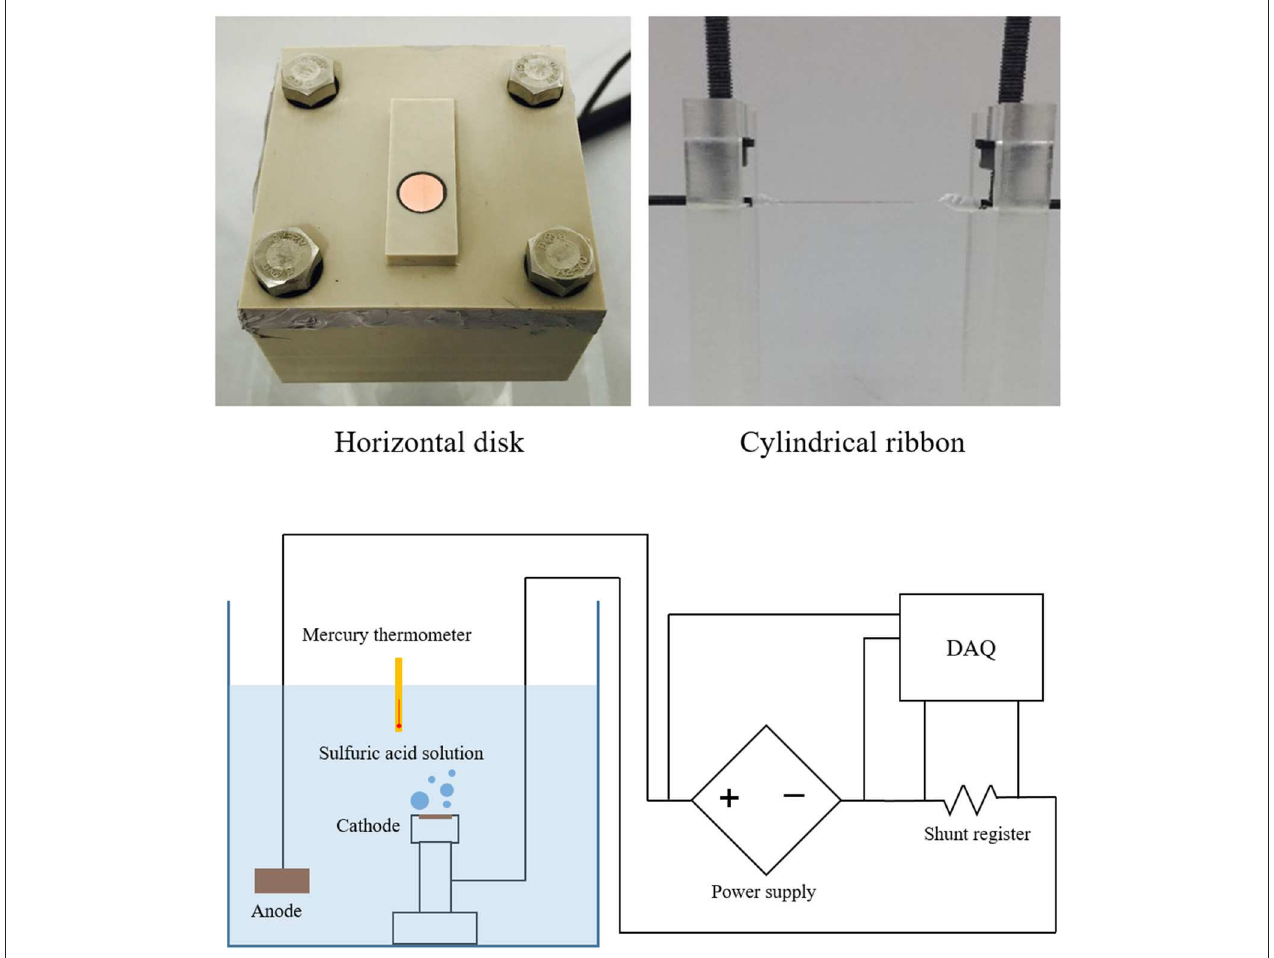
FIGURE 3 | Experimental apparatus and electric